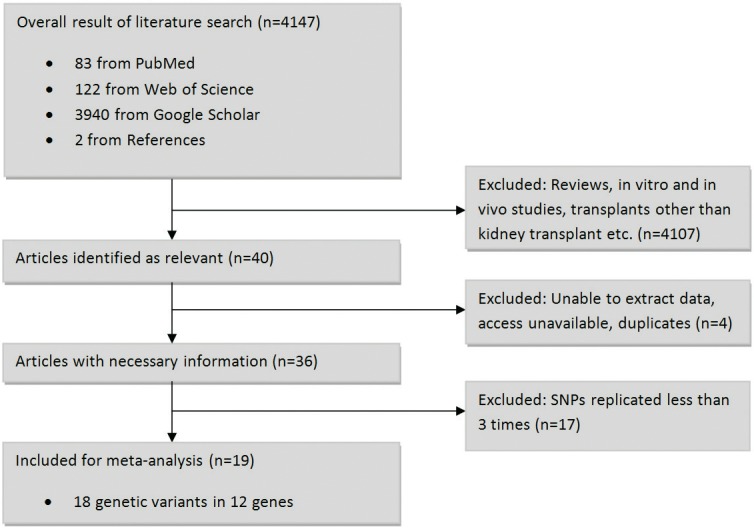
Flowchart describing the process of selection of eligible articles and variants for inclusion in the meta-analysis.